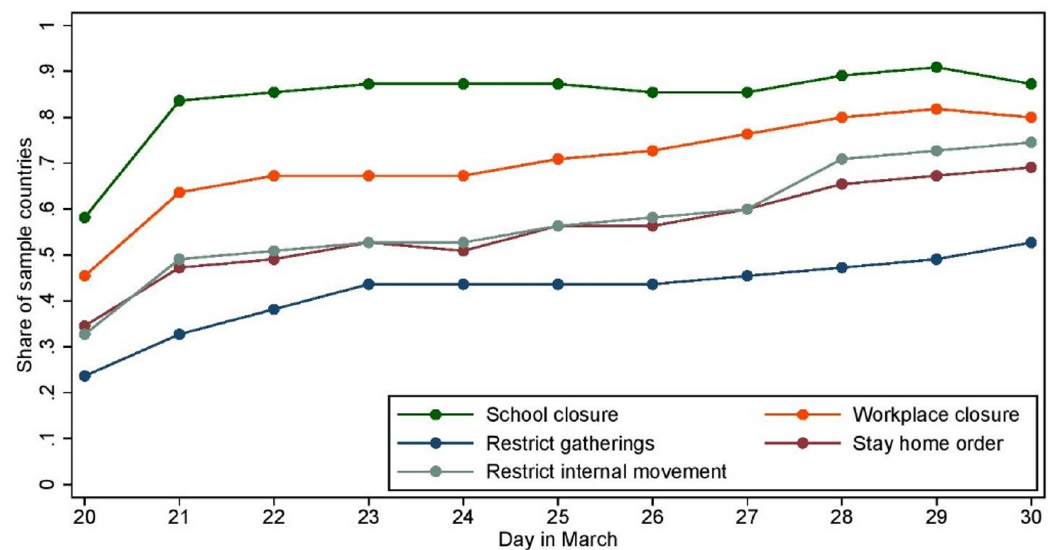
Fig 2. Timeline of the policies implemented in the control group. The figure reports the fraction of countries in the control group where the corresponding policy was enforced on each day provided on the x-axis.